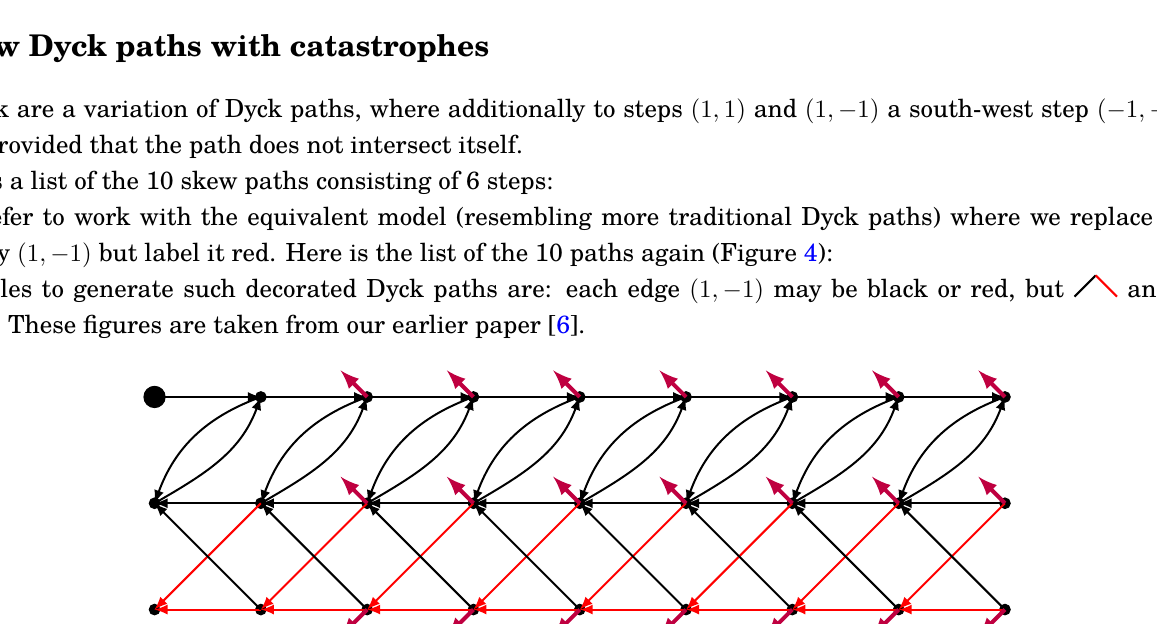
Figure 4: The 10 paths redrawn, with red south-east edges instead of south-west edges.